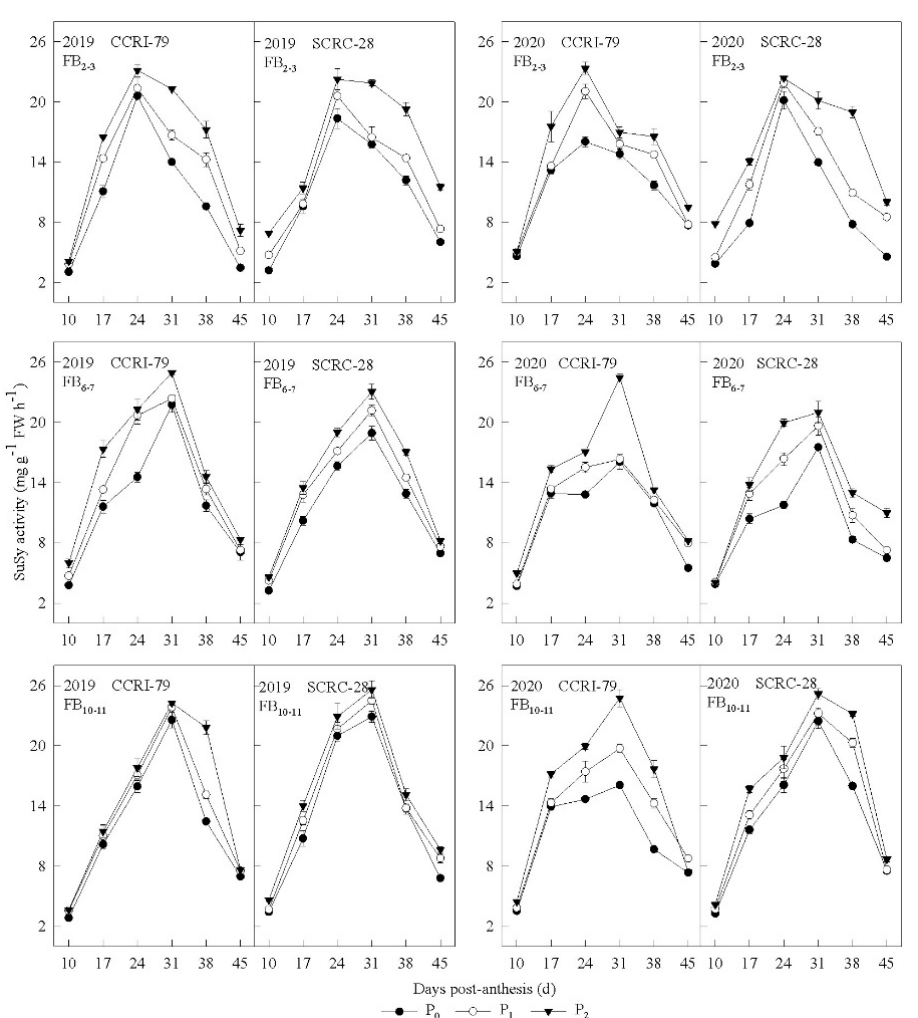
Figure 10. The effect of soil available phosphorus (AP) on the sucrose synthase (SuSy) activity of subtending leaves in 2019 and 2020 cotton ‐ growing seasons. d: day. FB: fruiting branch. P 0 : 3 ± 0.5